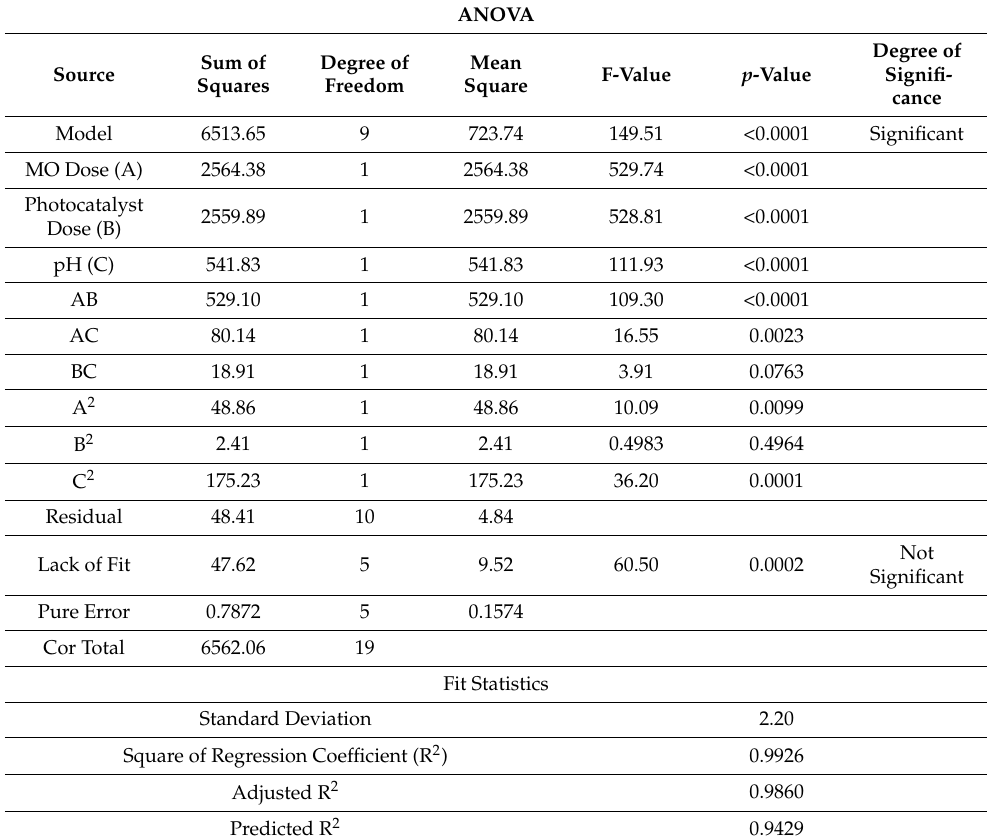
Table 2. The fit statistics and ANOVA analysis for the photocatalytic degradation of MO carried out in the presence of the CeO 2